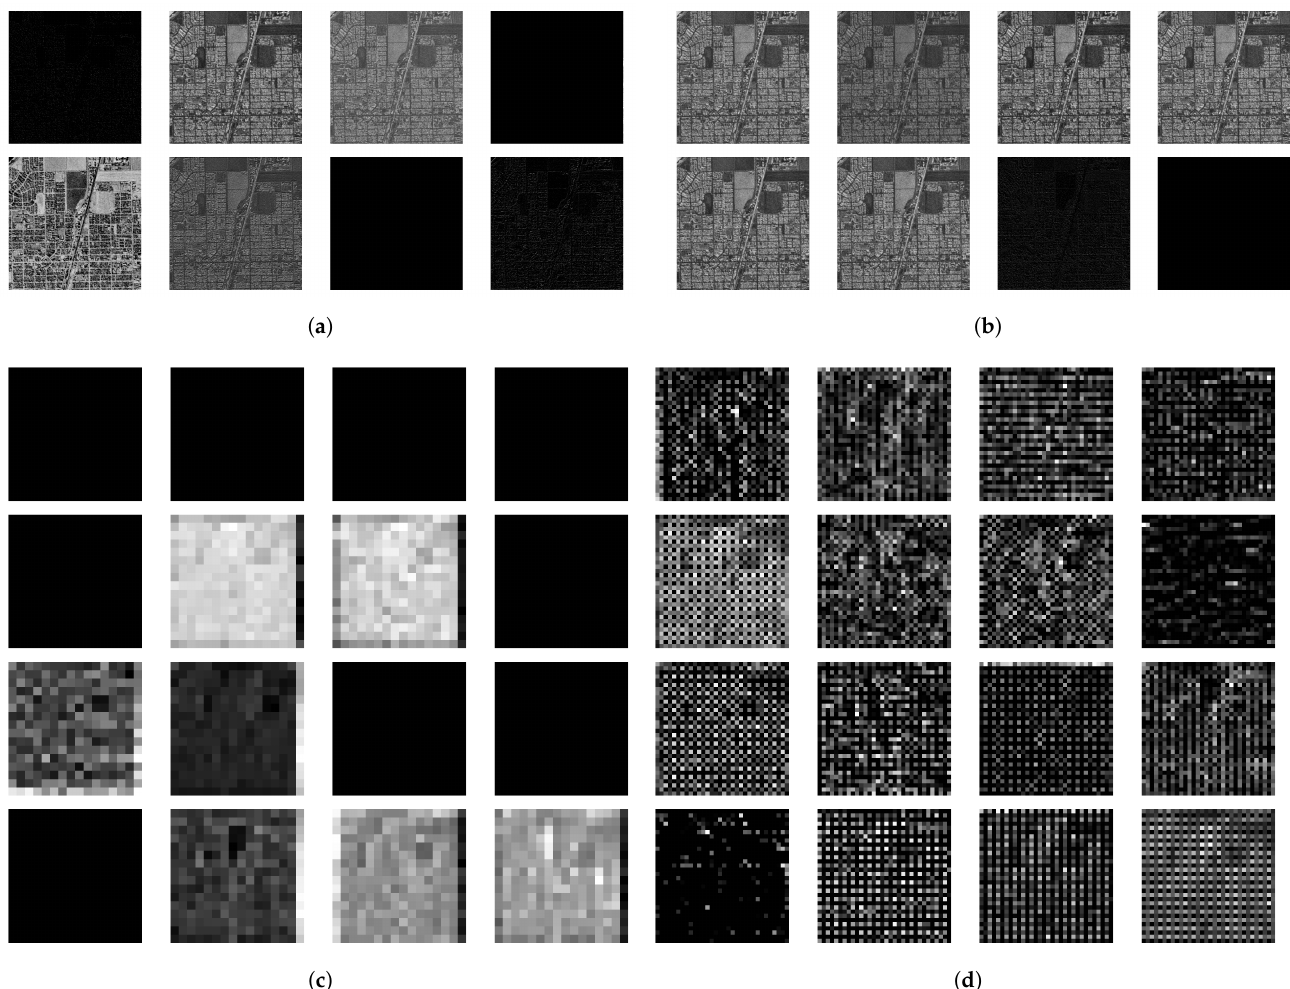
Figure A3. Features extracted from the layers of the Compressing CNN: ( a ) Compressing CNN— Without filters—Layer 0, ( b ) Compressing CNN—With filters—Layer 0, ( c ) Compressing CNN— Without filters—Last coding layer, ( d ) Compressing CNN—With filters—Last coding